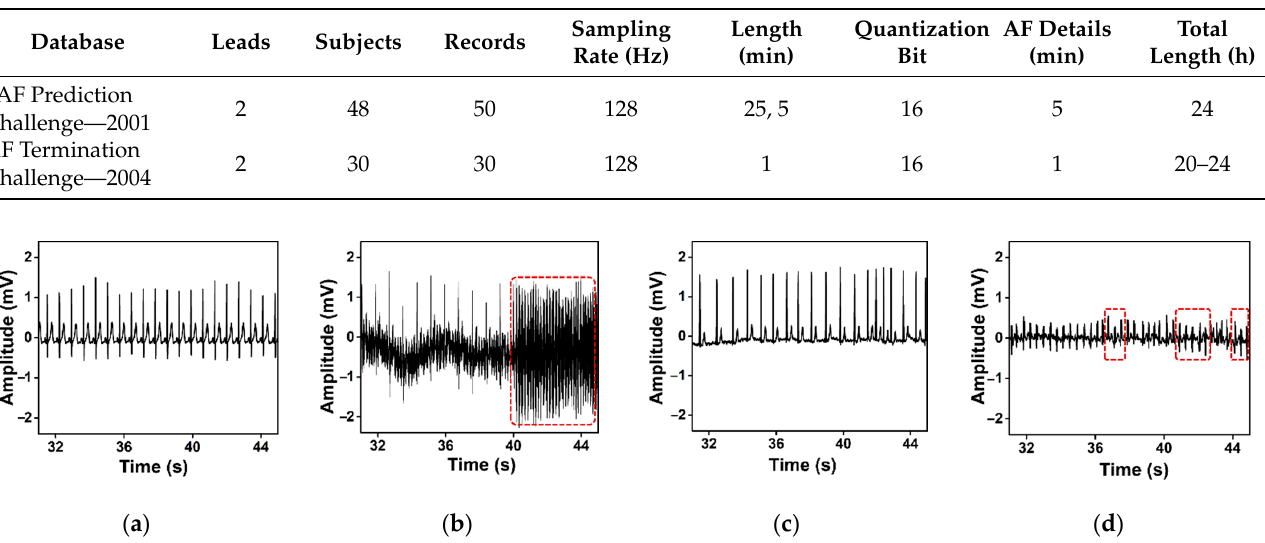
Figure 4. Representative ECG measurements of SR ( a , c ), and PAF ( b , d ) segments obtained from AFPDB and AFTDB, respectively. The identification of R-Peaks in PAF segments (within the red-rectangle area) are not easily identifiable.